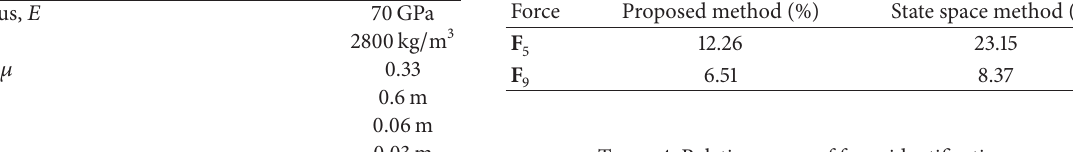
Table 4: Relative errors of force identification.